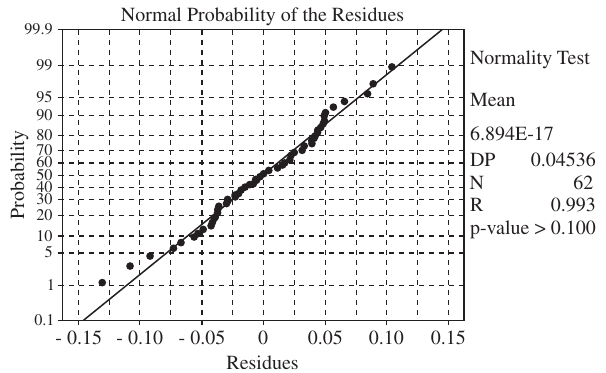
Figure 5. Graph of normal probability of the residues – reduced